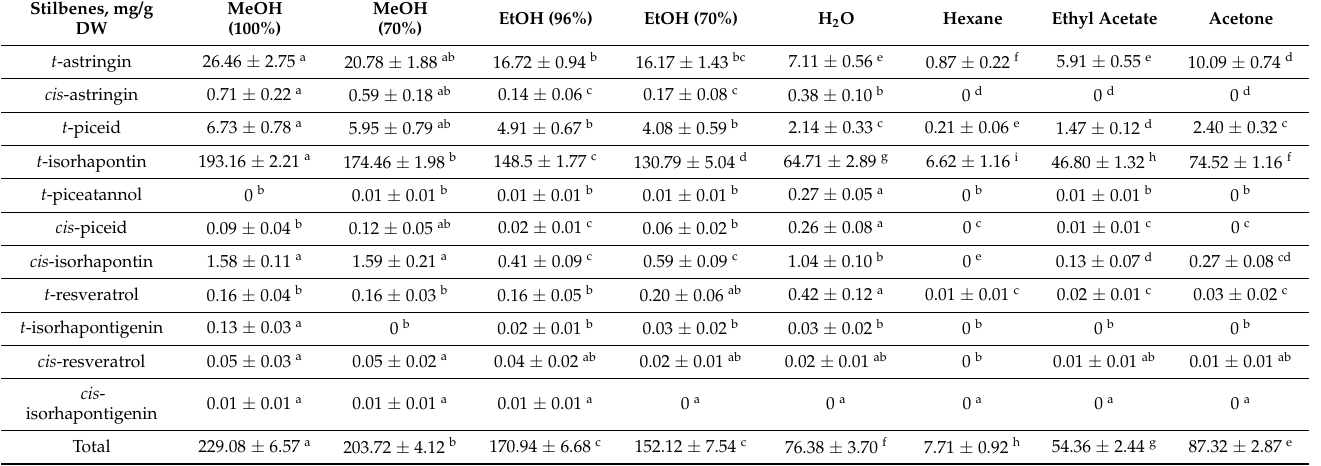
Table 2. Stilbene content in the bark of Picea jezoensis collected in winter after extraction with different solvents for 2 h at 60 ◦ C (mg per g of the dry weight (mg/g DW)). Means followed by the same letter (a, b, c, d, e, f, g, h, i, ab, bc, or cd) in one row were not different using Student’s t -test (three independent experiments). p < 0.05 was considered statistically